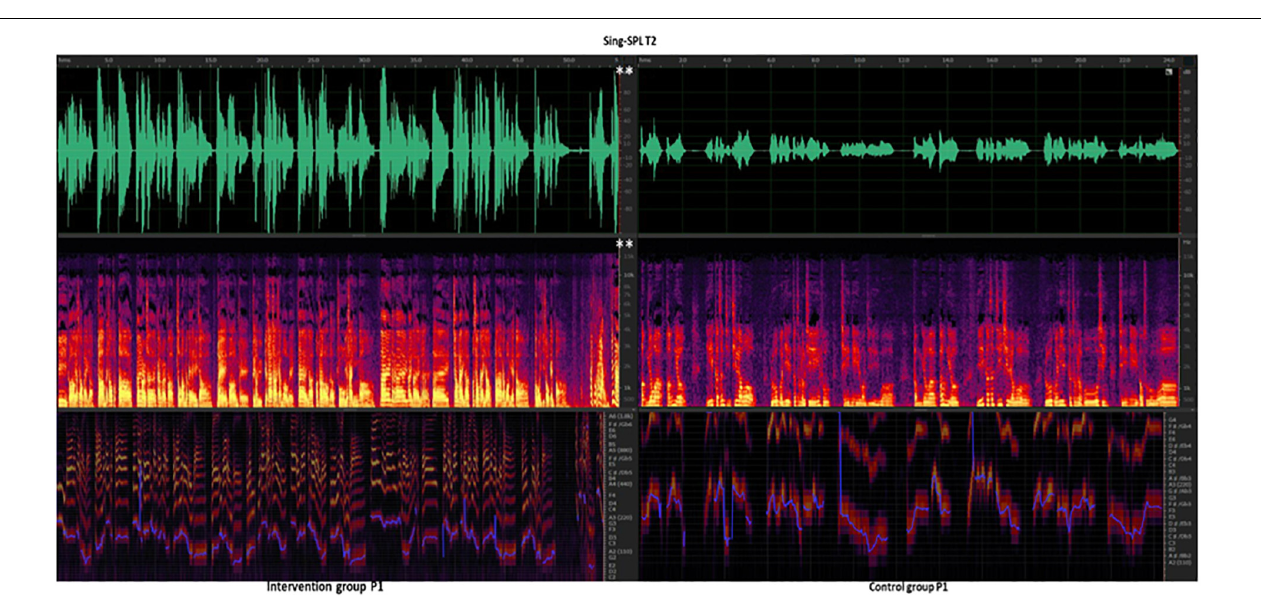
FIGURE 9 | Intervention group vs. Control group at T2 time point Sing-SPL (dBA) after the 12-week intervention. P, patient. Speech-SPL T2, intervention group patients vs. control group of Speak -SPL at T2 time point of spectral analysis. Line 1, green, the waveform spectrum represents the sound decibel (dBA) value; Line 2, purple, red, and yellow, fundamental frequency (F0, Hz) values; Line 3, purple, blue, indicates pitch (reference value). White ∗∗ indicates the p < 0.01, and the difference between groups is very